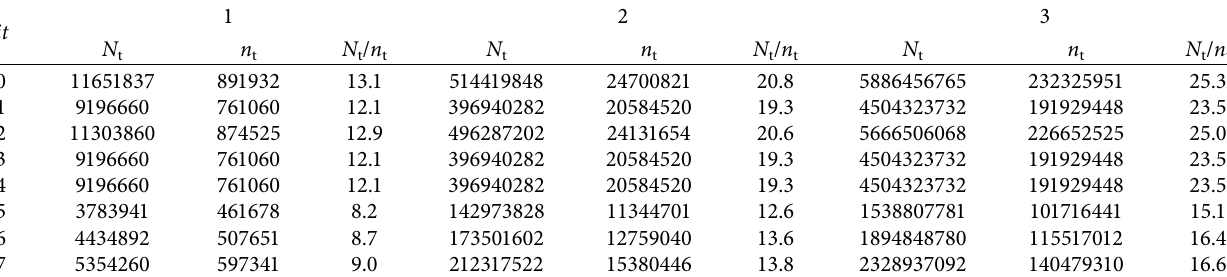
Table 18: Numbers of t -LAG temporal vector candidates N t and feasible temporal vectors N t